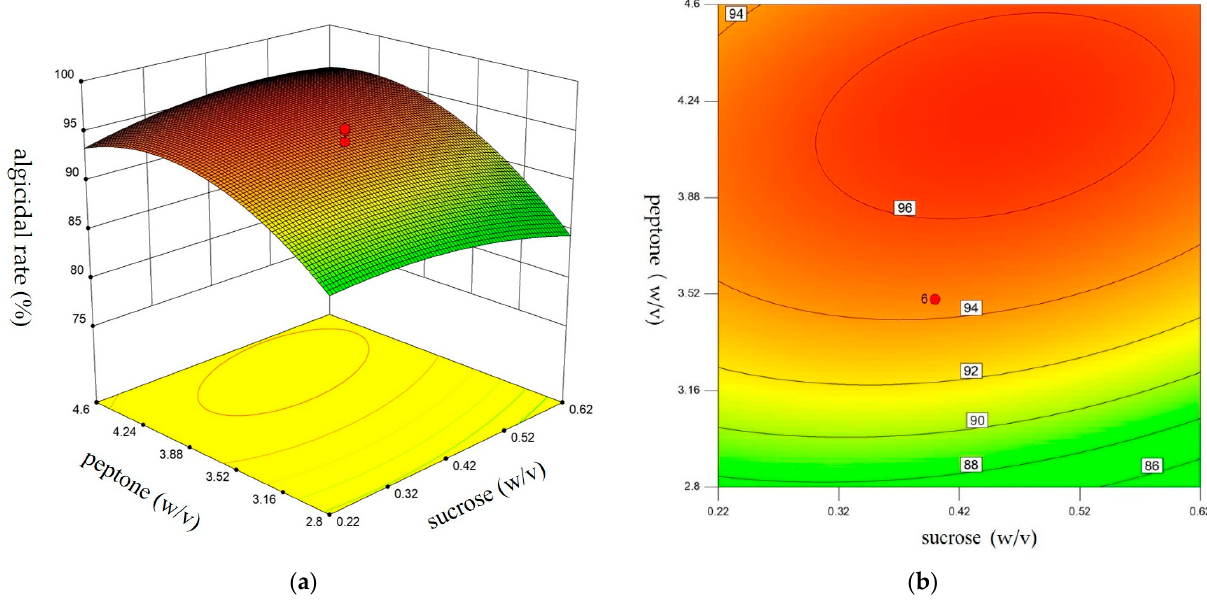
Figure 2. Three-dimensional response surface curve plots ( a ) and the contour plot ( b ) for algicidal rate of bacterial peptone and sucrose.